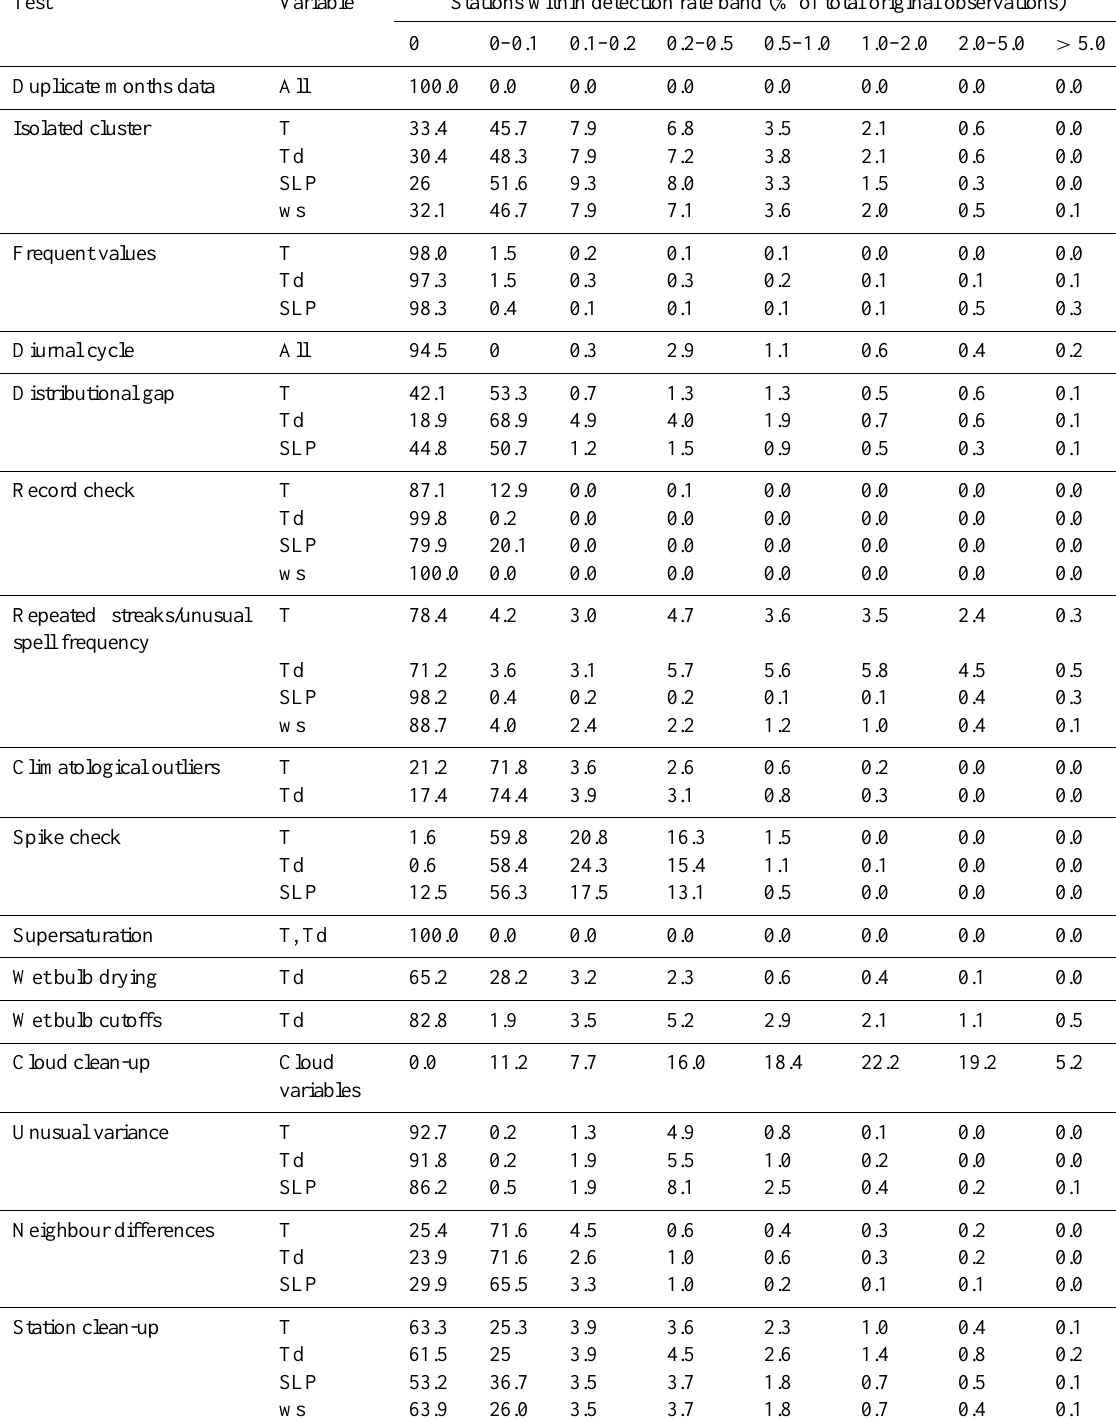
Table 9. As Table 6 but in percentages. Summary of removal of data from individual stations by each test for the 6103 stations in the .all dataset. Each row shows the percentage of stations that had fractional removal rates in the seven bands for the test and variable